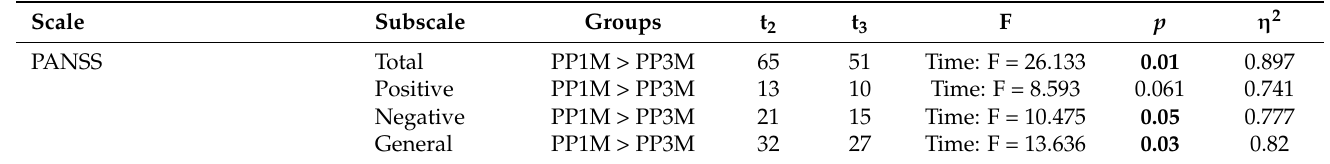
Table 4. General Linear Model repeated measures of assessments and clinical variables between PP1M and